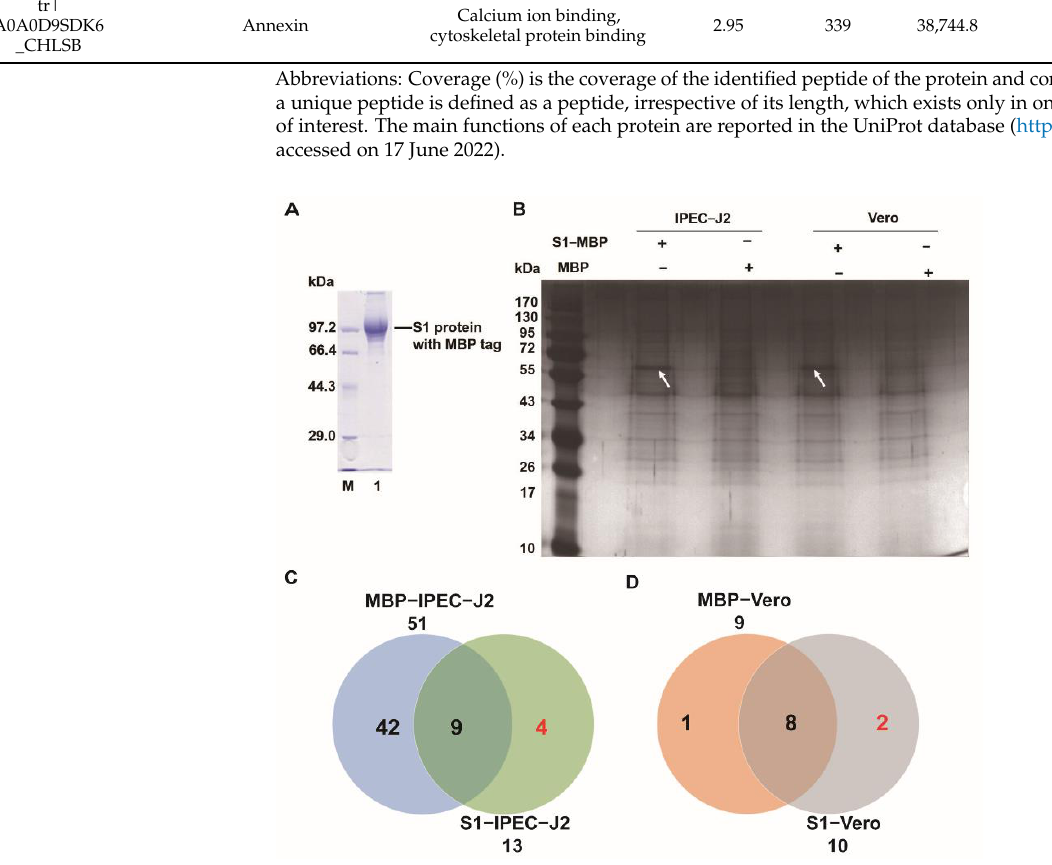
Figure 1. Analysis of the interaction between PEDV S1 and the plasma membrane protein of Vero or IPEC-J2 by SPR assay. ( A ) SDS-PAGE (12% w / v ) is used to determine the expression of the recombinant PEDV S1 protein. Lane M: PageRuler Pre-stained Protein Ladder; lane 1: purified S1 protein with MBP tag. ( B ) The interaction between PEDV S1 and the plasma membrane protein of Vero or IPEC-J2 is measured by an SPR assay. The eluted proteins are separated by electrophoresis on 12% gels with silver staining. The arrow indicates the differentially interacting proteins between S1- MBP and plasma membrane protein of Vero or IPEC-J2 compared to the control group (MBP/plasma membrane protein of Vero or IPEC-J2). ( C , D ) Venn diagram of the interacting proteins in 55 kDa protein band by LC-MS/MS analysis. The total numbers of plasma membrane proteins of Vero or IPEC-J2 interacting with S1 protein or MBP-tag are labeled below S1 protein or MBP tag. Table 1. Characteristics of differentially interacting proteins identified in PEDV S1 with the plasma membrane protein of Vero or IPEC-J2. Table 2. we extracted membrane proteins of IPEC-J2-infected PEDV and used an